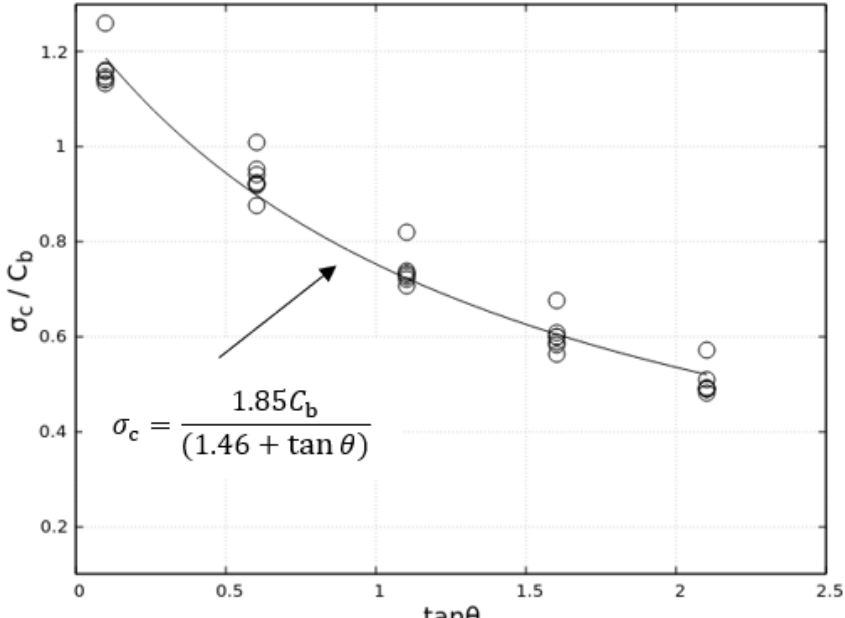
Figure A5. Plot of Y c /Y b against v b fitted with Equation (A1).